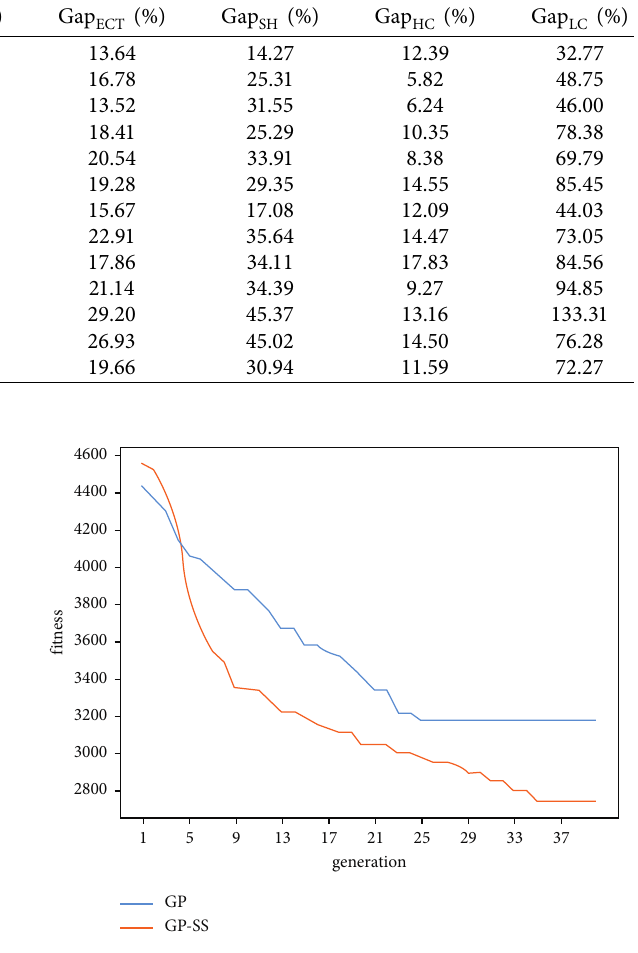
Figure 3: Evolving process of GP-SS and